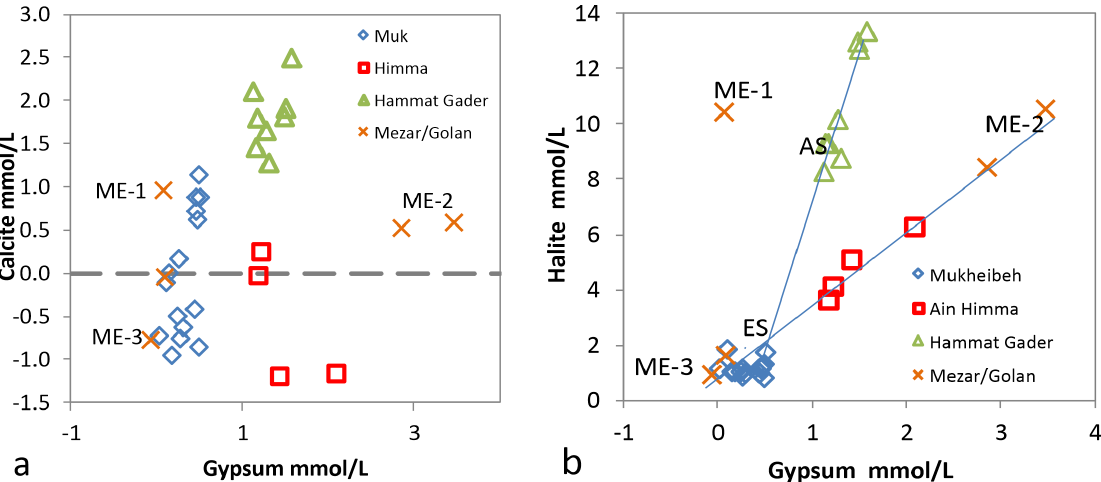
Figure 9. Cross plots of minerals. ( a ) Amounts of gypsum and calcite in WRI based on the assumption that ε brine can be estimated after Equation (2). ( b ) Amounts of halite and gypsum in WRI+brine. Here ε brine is assumed to be zero and its contribution appears together with those of the